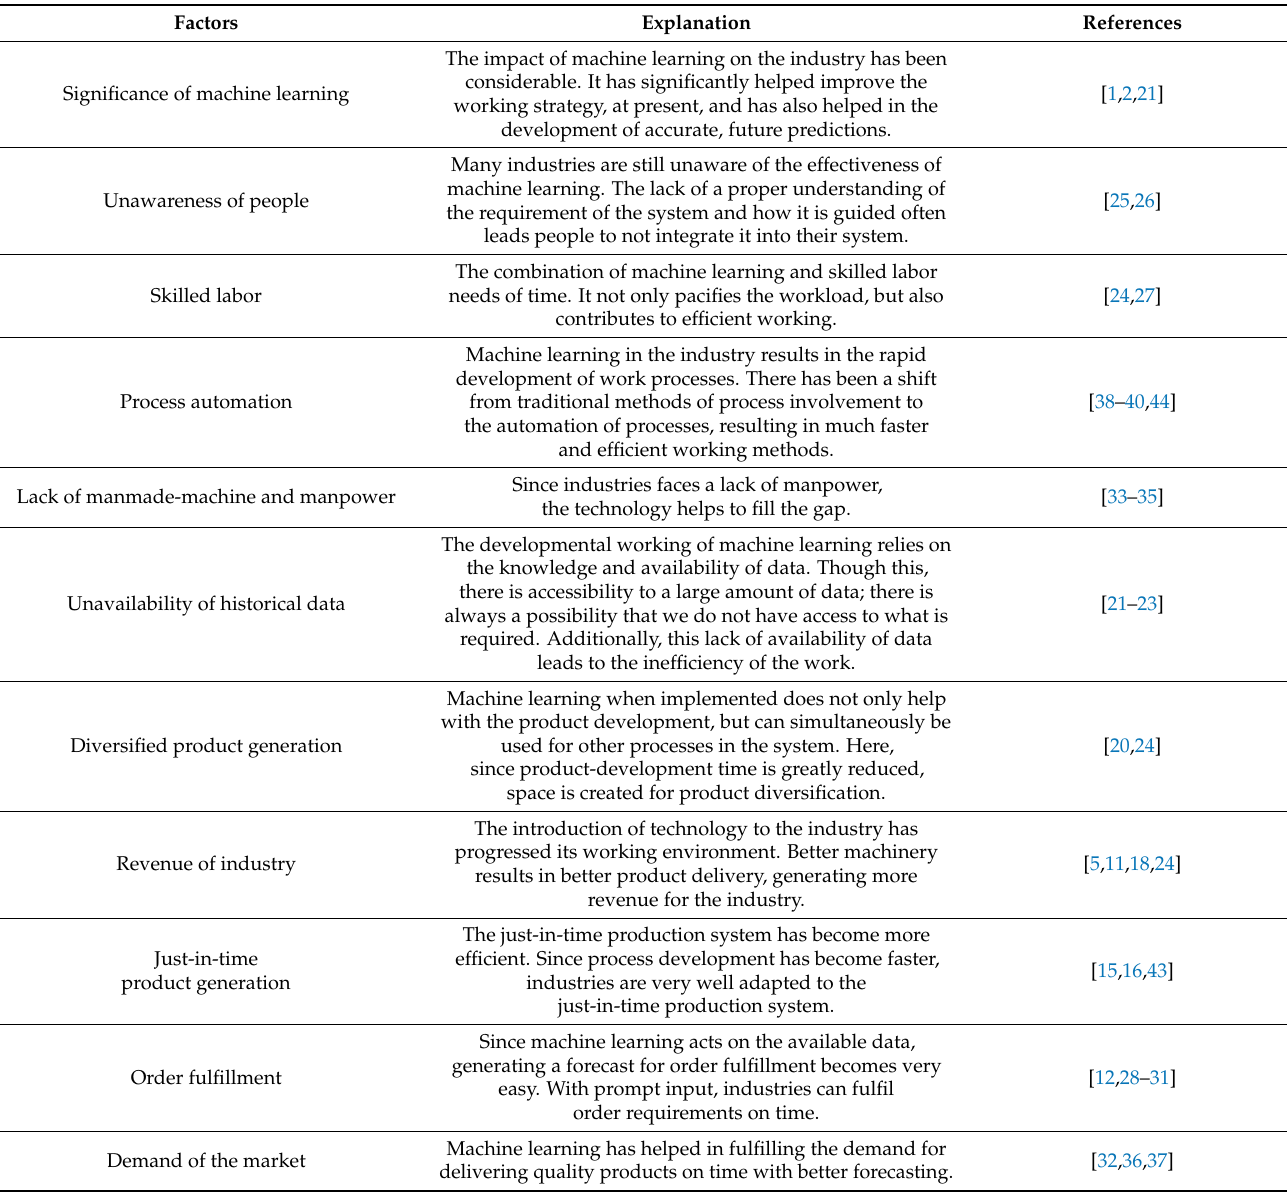
Table 1. Factors with their